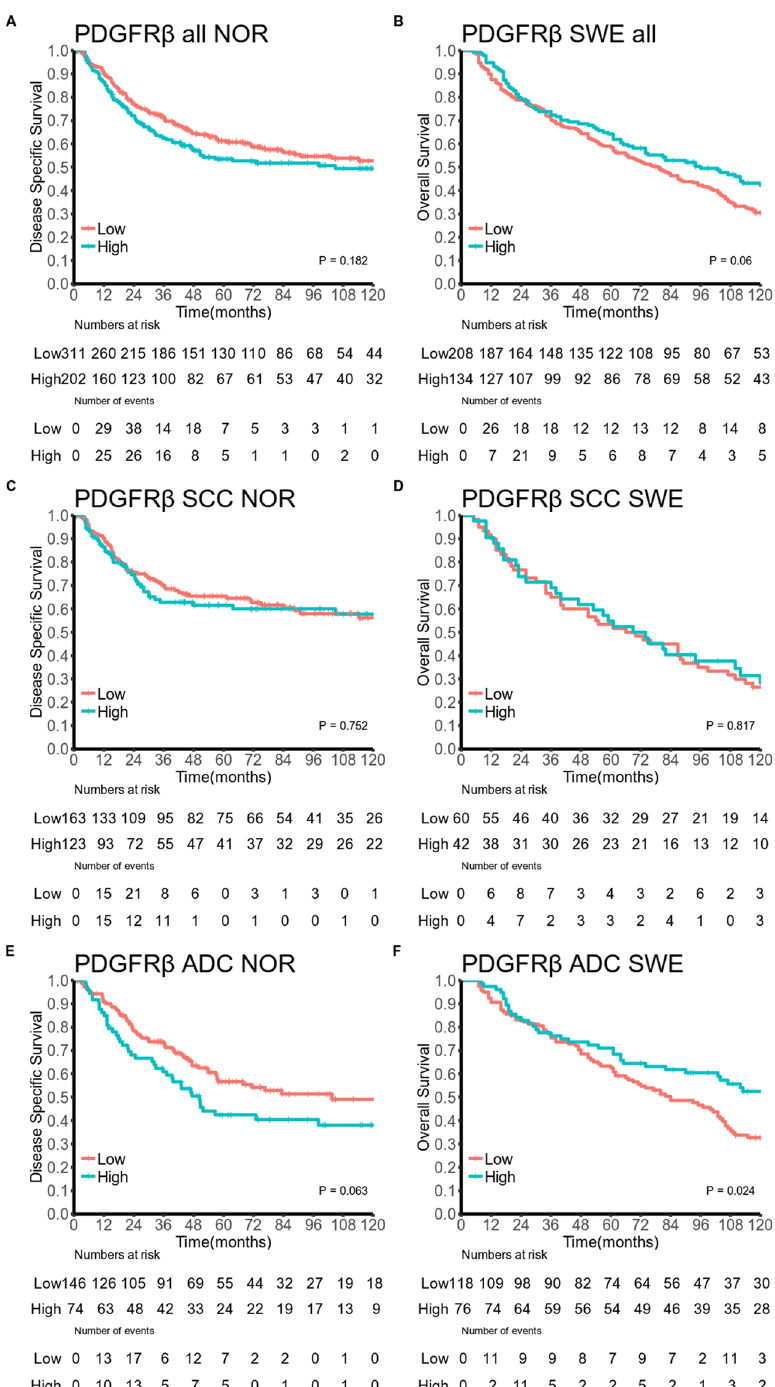
Figure 3. Survival curves for PDGFR β expression in the overall cohorts and in the SCC and ADC subgroups for the Norwegian cohort ( A , C , E ) and the Swedish cohort ( B , D , F ). Abbreviations: PDGFR, platelet-derived growth factor receptor; SCC, squamous cell carcinoma; ADC,